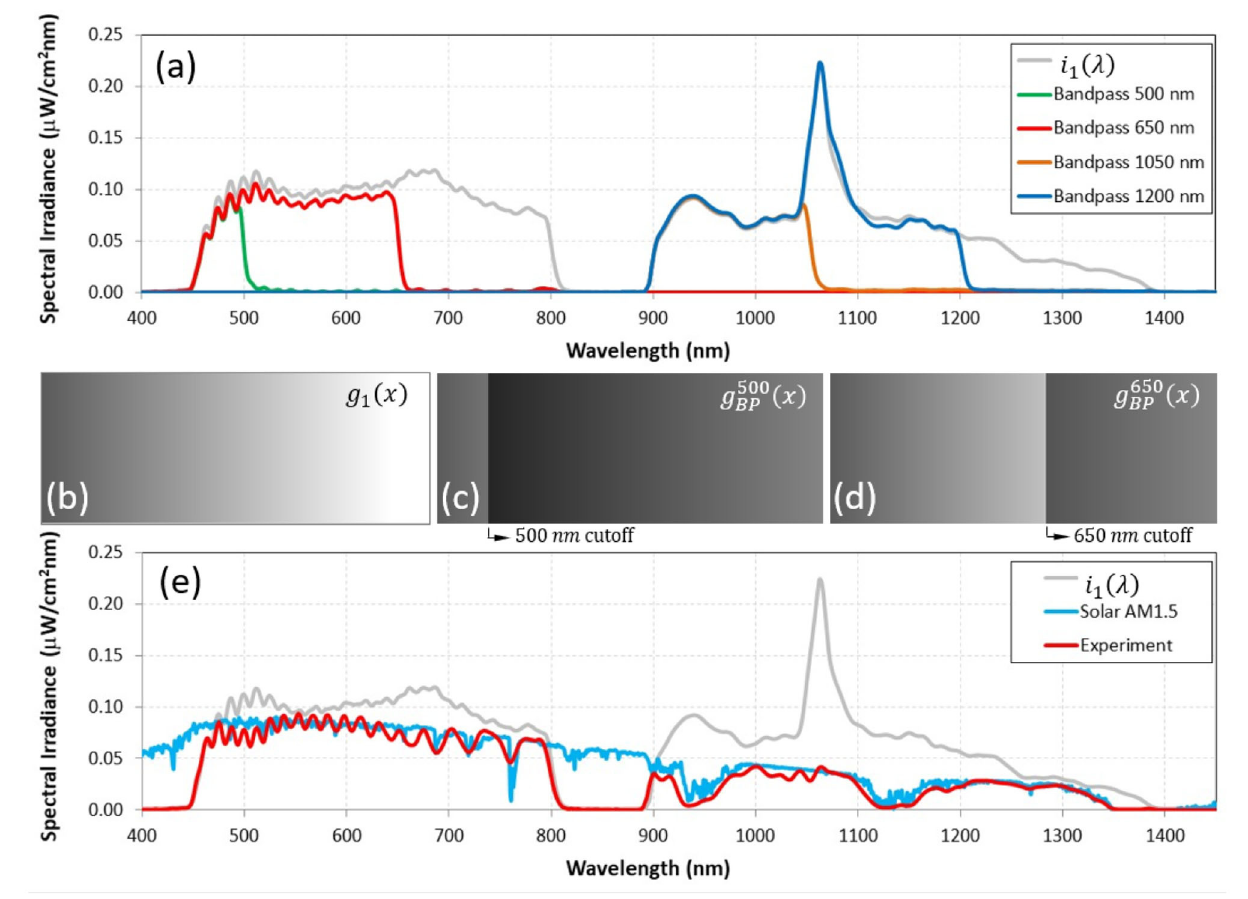
FIGURE 3 | (a) Experimental measurements for low bandpass illumination with cutoff wavelengths at 500, 650, 1,050, and 1,200nm. (b) Gray level function g 1 ( x ) generating i 1 (λ) . (c) Gray level function g 500 BP ( x ) generating the bandpass at 500nm. (d) Gray level function g 650 BP ( x ) generating the bandpass at 650nm. (e) Comparison of the solar AM1.5 spectrum with its experimental reproduction on the supercontinuum